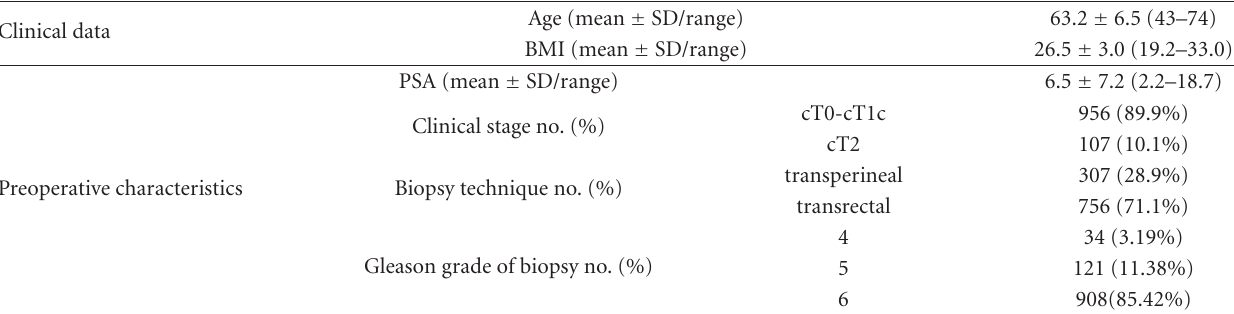
Table 1: Clinical data and preoperative characteristics of the 1,063 patients.